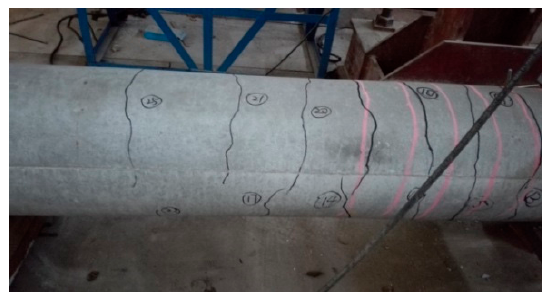
Figure 6. Some of the cracks generated in the PRC tube column specimen during loading.